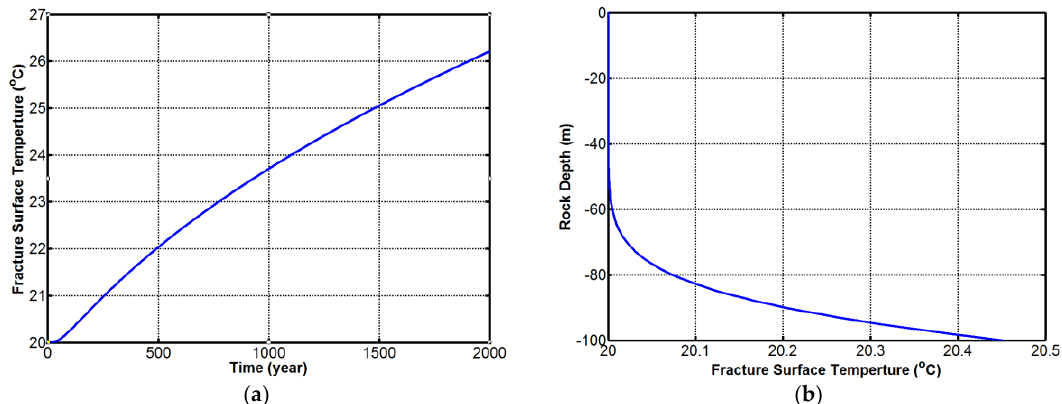
Figure 4. Fracture surface temperature increases over time due to heat flux. ( a ) Temperature profile at the fracture surface with respect to time, in year; ( b ) Temperature profile with respect to rock depth at fixed time t = 5 years, with z = −100 m as the depth of the uniformly applied geothermal heat flux. In both figures, the initial temperature of the fracture wall rock is T 0 = 20 ◦ C, heat flux q f = 0.06 W / m 2 , thermal conductivity k = 1.88 W / (m · K)(Limestone value from [36]), thermal di ff usivity is κ = 10 − 6 m 2 / s, and the total rock depth is 100 m.